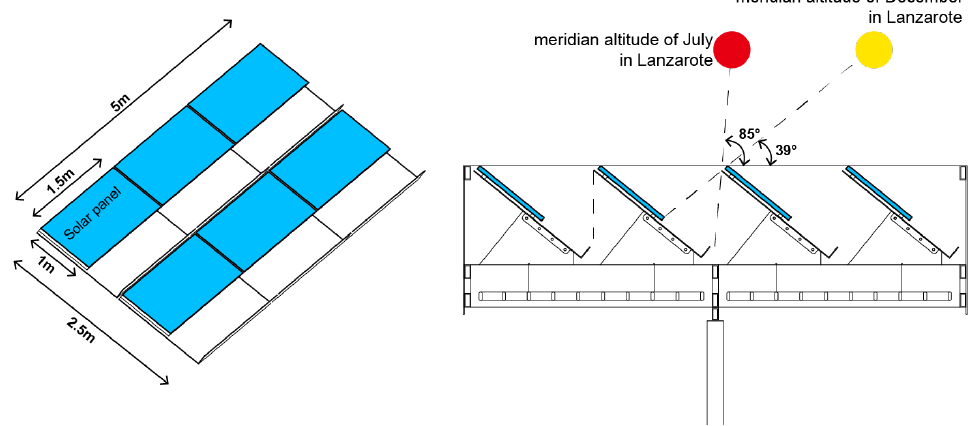
Figure 4. Conceptual diagram of solar panels to be installed on the roof of the pergola.